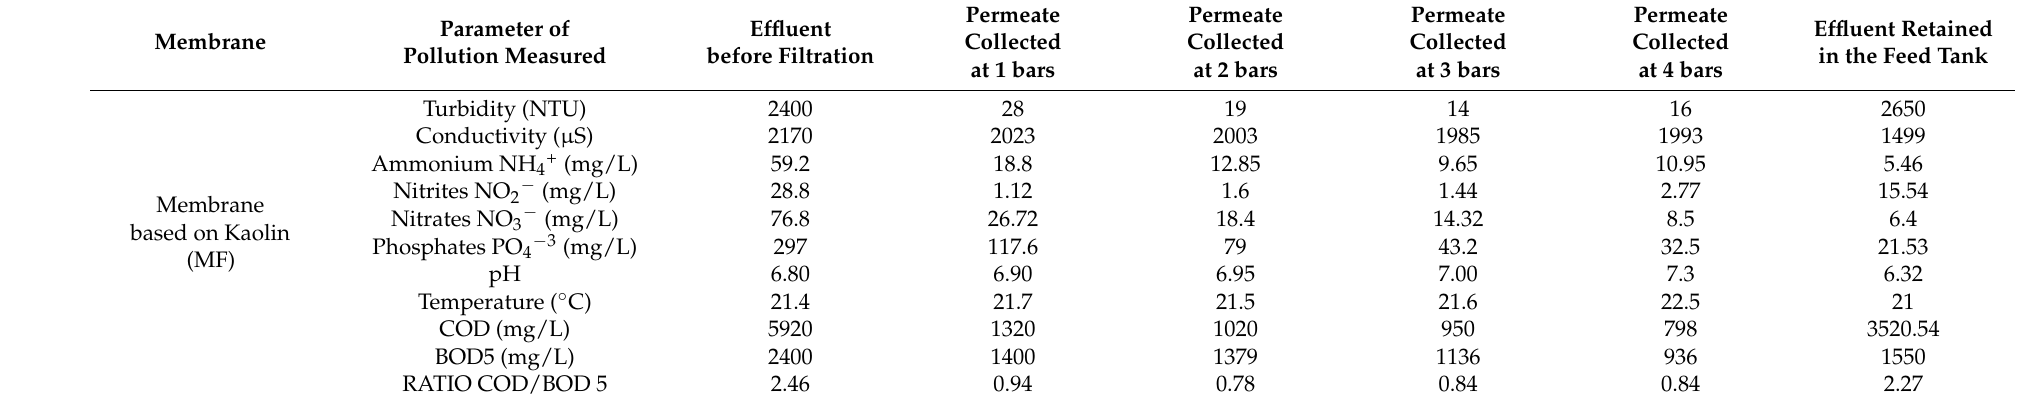
Table 6. Results of the physicochemical pollution parameters measured on the studied effluent using membrane based on kaolin